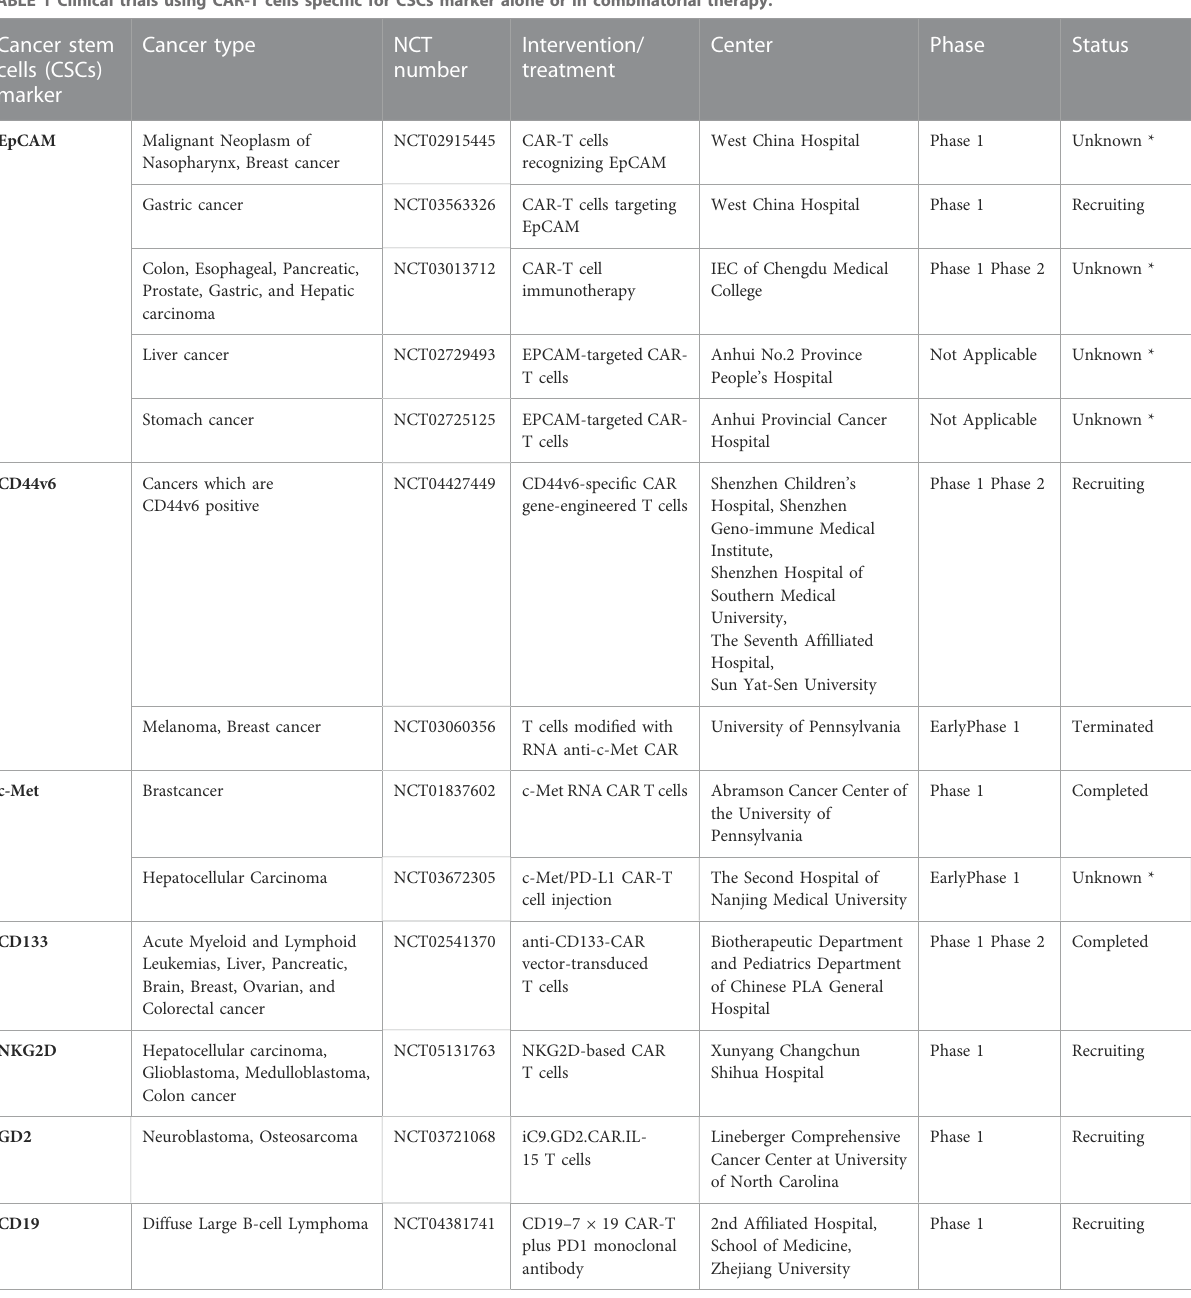
TABLE 1 Clinical trials using CAR-T cells speci fi c for CSCs marker alone or in combinatorial therapy. Cancer stem cells